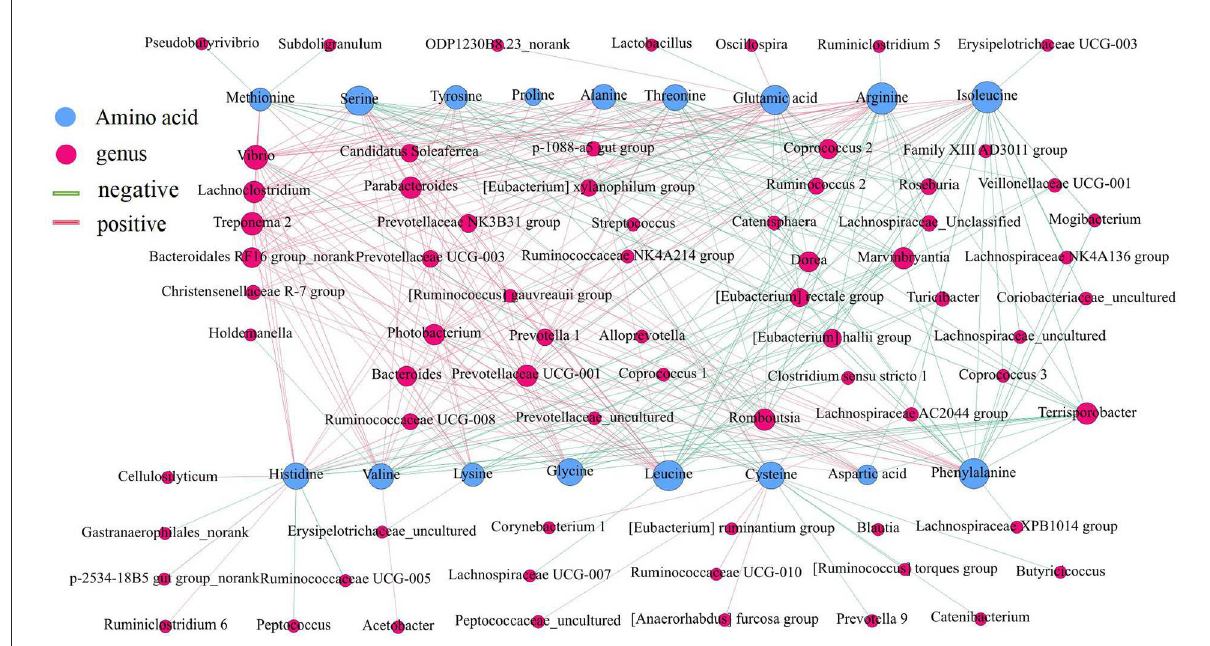
FIGURE10 Correlation analysis between the microbial community and the concentrations of amino acids in the intestine of pigs. The association between the top 100 genera in the colon and the amino acids was analyzed using Spearman’s correlation method. The node size is proportional to the number of